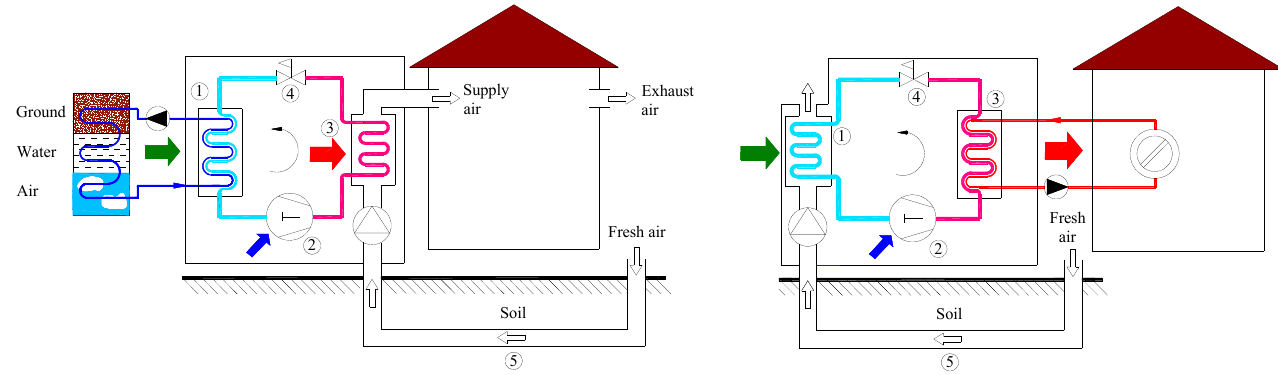
Figure 1. Earth to air heat exchanger used for an air supply in a ventilation system ( left ) and coupled to the air source heat pump ( right ) (1—evaporator, 2—compressor, 3—condenser, 4—expansion valve, 5—earth to air heat exchanger).